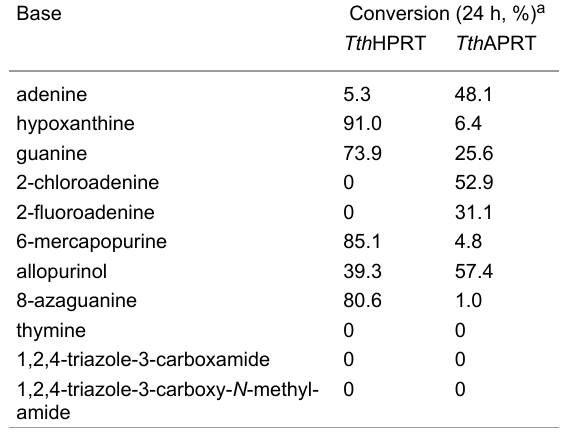
Table 3: Substrate specifity of Tth HPRT and Tth